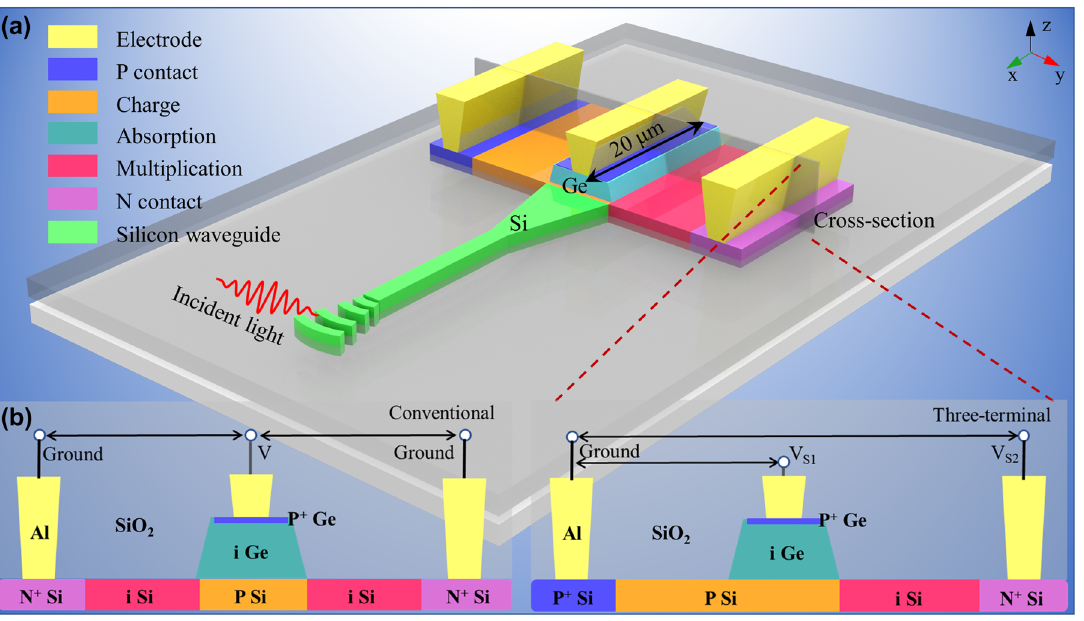
Figure 1: The structure of the wavegiude three-terminal SACM SPAD. (a) The 3D illustration of the waveguide three-terminal SACM SPAD. (b) The schematic cross-section diagrams of the conventional and three-terminal SACM SPAD. The figures are not to actual